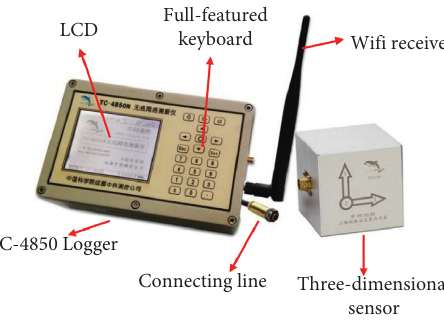
Figure 6: TC-4850 blasting signal